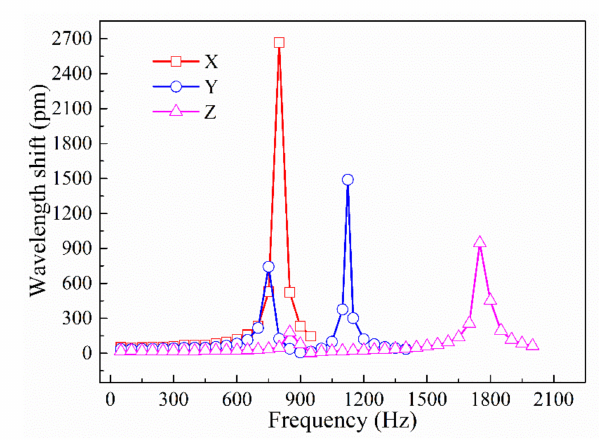
Figure 19. Amplitude frequency curves of accelerometer in x-, y-, and